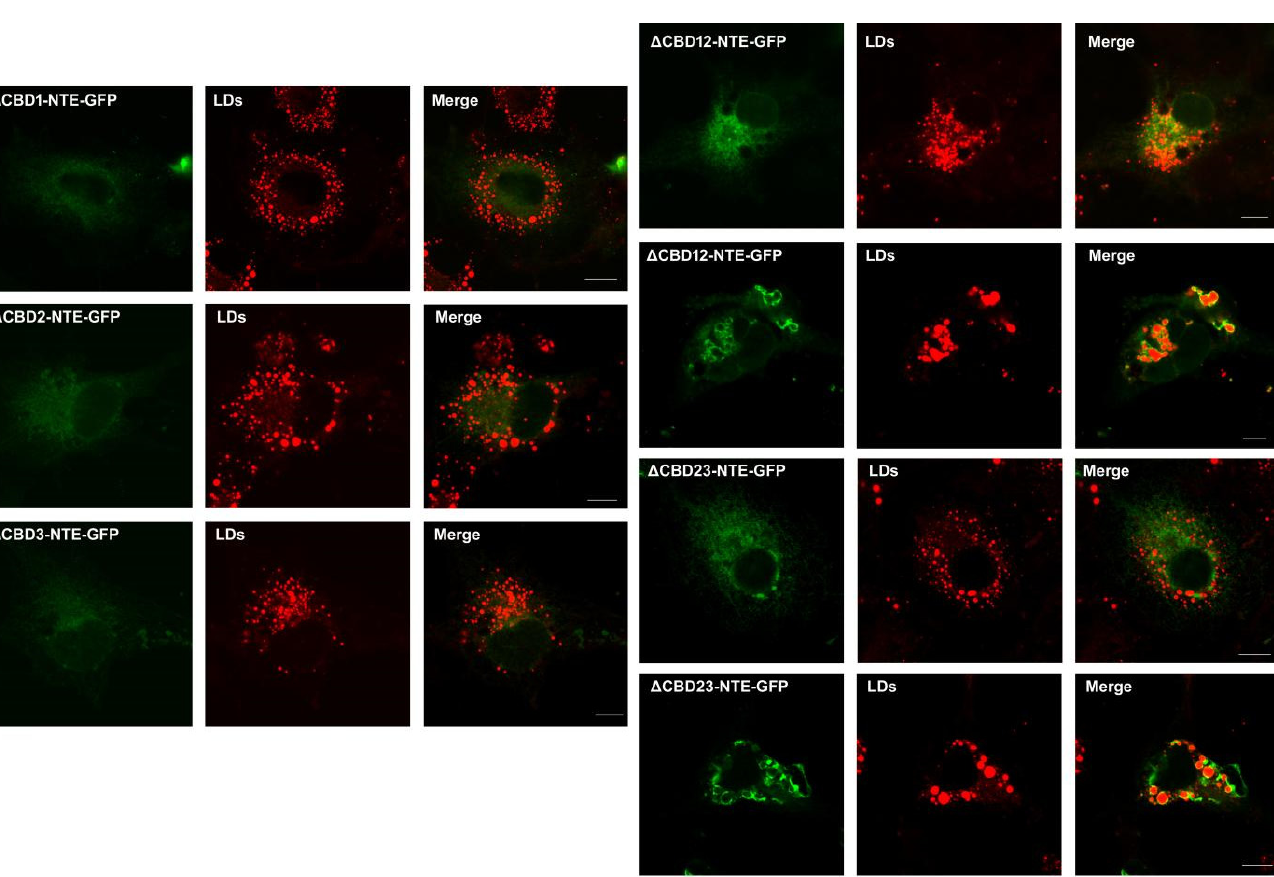
Figure 2. Functional contribution of CBD in NTE to LD targeting. After tranfection with NTE-GFP truncation mutants for 24 h, COS-7 cells were loaded with 0.2 mM for 12 h to induce LD formation. LDs were stained with HSC LipidTOX TM Deep Red neutral lipid stain and images were acquired by confocal fluorescence microscopy. Figures are representative of at least three experiments. Scale bars, 10 μ m.